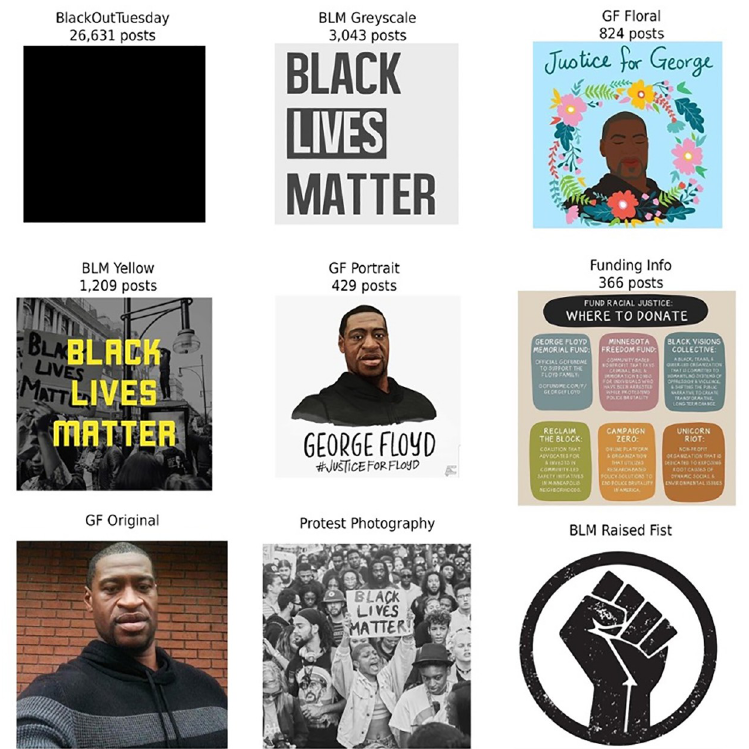
Fig 3. Top photos that emerged from the 2020 George Floyd protests. From top to bottom and left to right, we have the Black Out Tuesday Square (a), logos and icons of the Black Lives Matter movement (b, d, i), portraits of George Floyd (c, e, g), and photos of protest